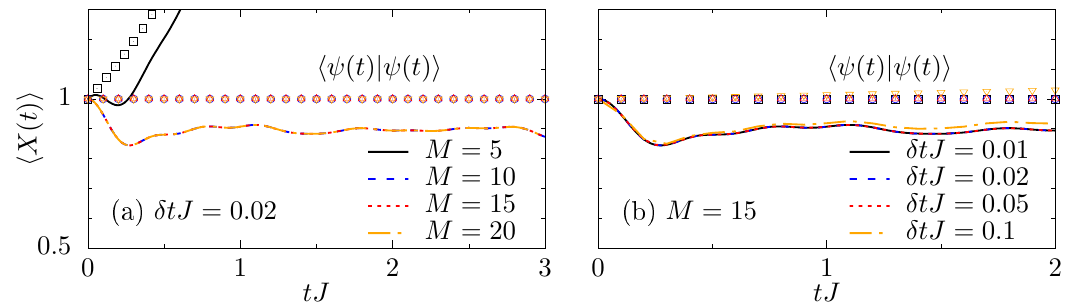
Figure 8: Dynamics of the transverse magnetization 〈 X ( t ) 〉 for a cluster of size × L = 7 × 3 (with OBC), initial state | ψ ( 0 ) 〉 = |→〉 , and transverse field g = 3.044. L x y The symbols indicate the norm 〈 ψ ( t ) | ψ ( t ) 〉 . (a) Fixed time step δ tJ = 0.02 and varying expansion order M . (b) Fixed M = 15 and varying δ tJ